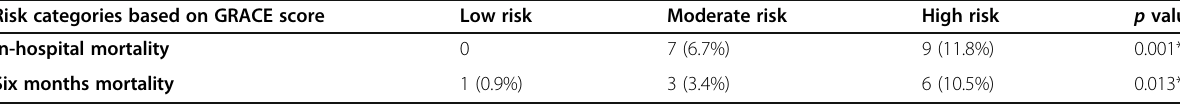
Table 1 Estimation of mortality with respect to risk categories based on GRACE score Risk categories based on GRACE score